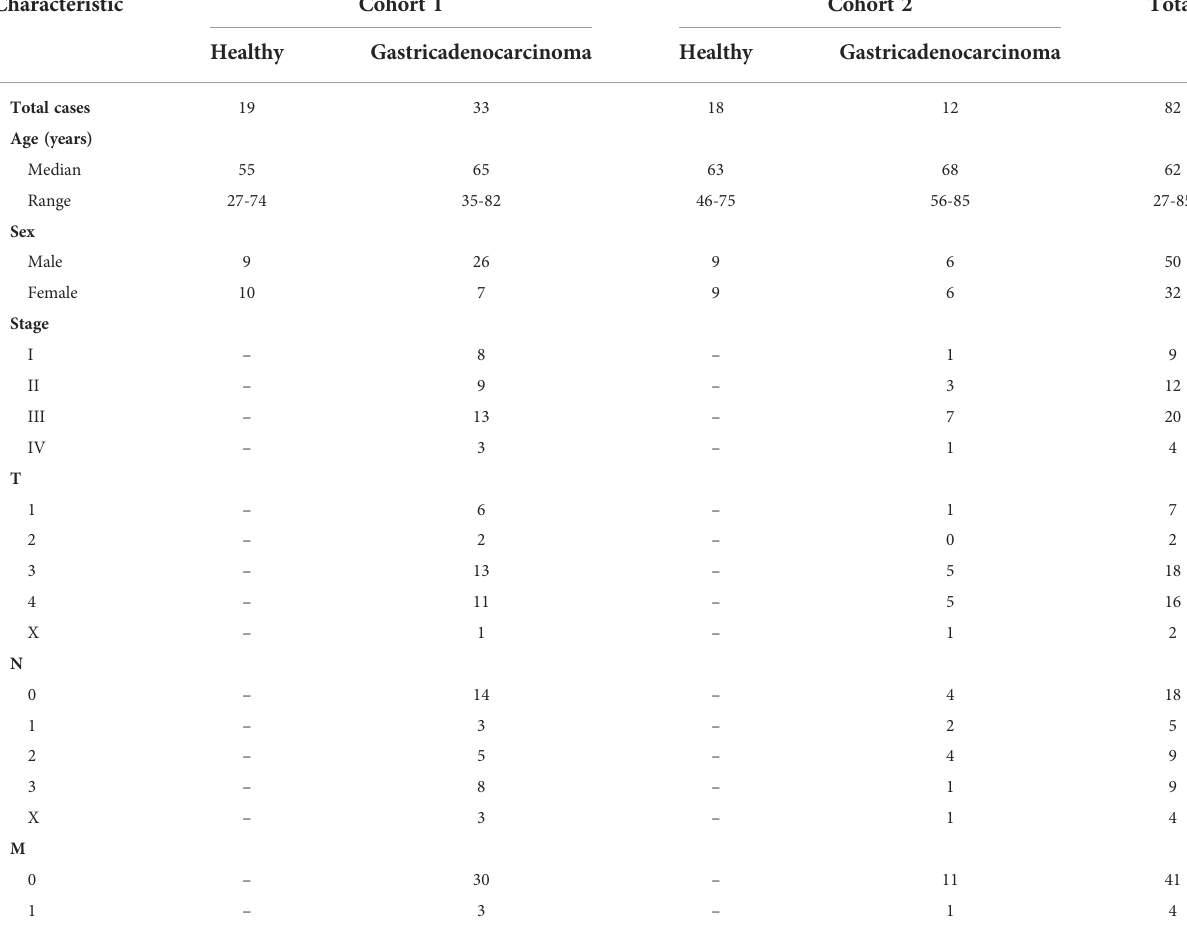
TABLE 1 Clinical information (X denotes information unavailable).